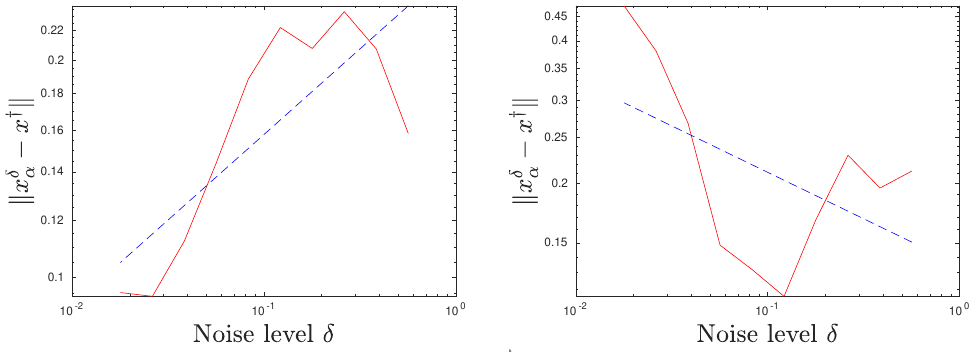
Figure 5. Regularization error (cid:107) x δ α − x † (cid:107) X and regression line for different noise levels δ on a log-log scale. x † ( t ) = 1, a priori parameter choice according to Equation (37) with κ α = 3.5 ( left ) and κ α = 5.5 ( right